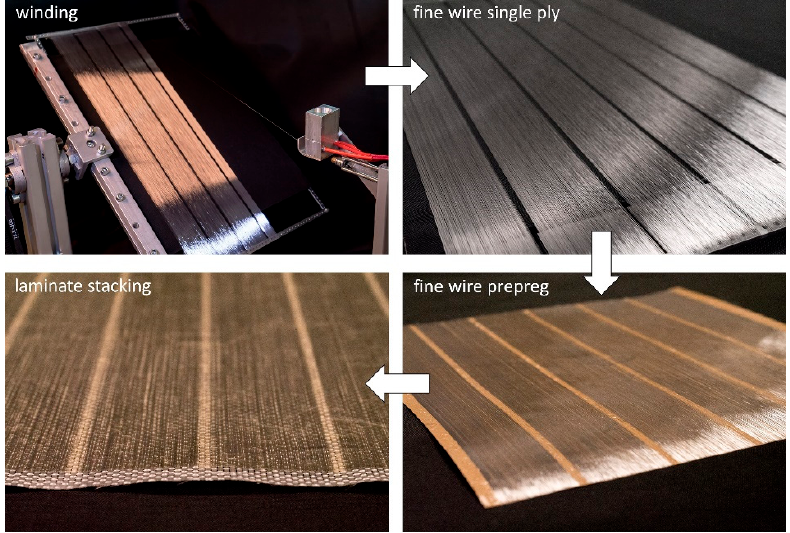
Figure 5. Steps of the aluminum fiber integration.